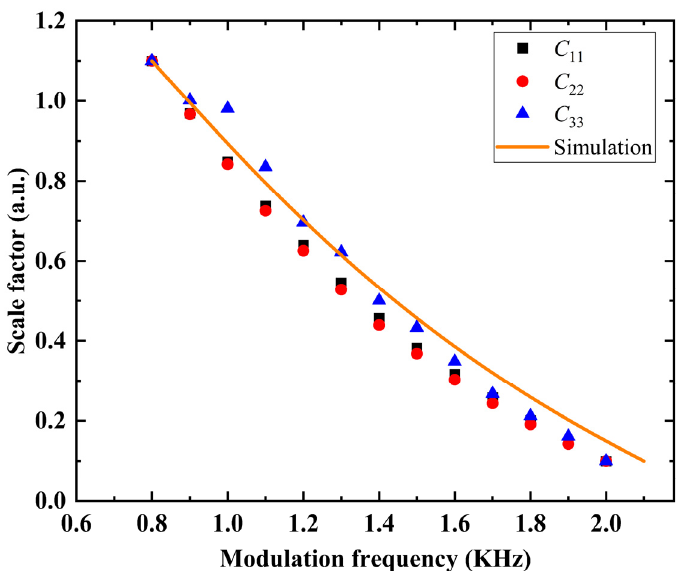
Figure 5. Three-axis scale factors under different modulation frequencies. The square, round, and triangular points represent the experimental results. The orange curve is the simulation result.